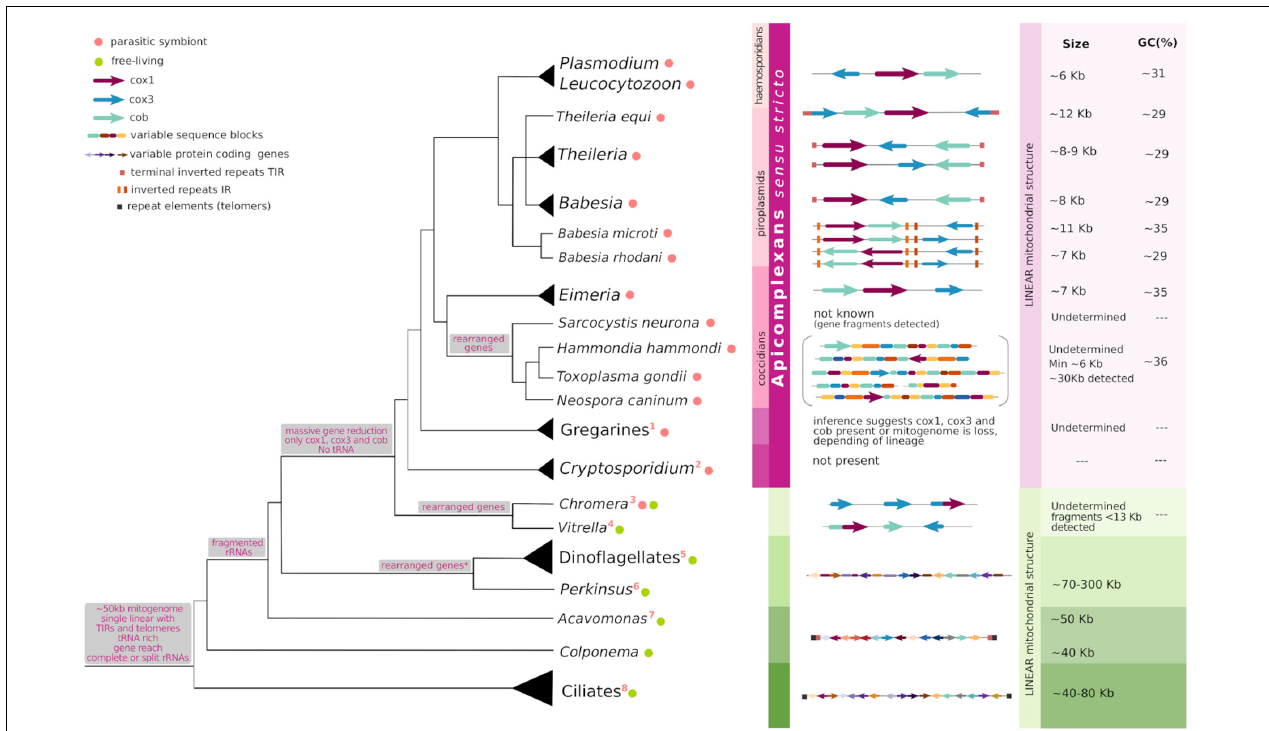
FIGURE 1 | Commonalities and peculiarities of apicomplexan mitogenomes in light of their evolution. The tree shows evolutionary relationships among taxa in Alveolata, the gray branches at the base of Alveolata and Apicomplexa depict less confidence for the topology shown. Gray boxes associated with some tree nodes describe the characters present or lost at the hypothetical common ancestors. To the right of taxon names, colored circles indicate the organism lifestyle following the legend and numbers enumerate peculiar features of each lineage (see below). At the middle, the horizontal figures represent the size, topology and gene content of known mitogenomes. The different elements follow the shape and color depicted in the legend. To the right, when the data is available, approximated mitogenome size and GC content (%) are indicated. This figure results from an adaptation of Figure 7 in Namasivayam et al. (2021), Figure 5 in Hikosaka et al. (2010), Figure 5 in Schreeg et al. (2016), and Figure 1 in Janouškovec et al. (2019). 1: mitogenome is lost in some gregarines; 2: mitogenome loss; 3: cox1–cox3 fusion, cob loss; 4: cob-cox1 fusion; 5: fragmented cox3 and cob-cox3 fusion, extensive RNA editing; 6: cox3 loss and translational frameshifting in cox1 ; 7: cox2 encoded for in the mitogenome; 8: bipartite rRNAs, few tRNAs, cox3 loss, bipartite nad1